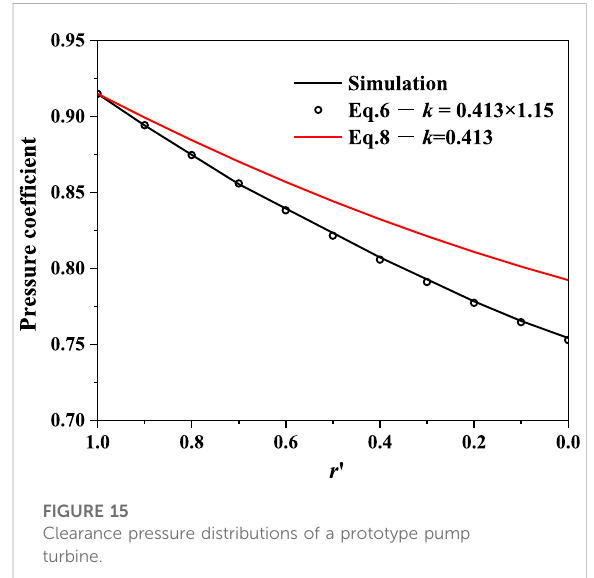
FIGURE 15 Clearance pressure distributions of a prototype pump